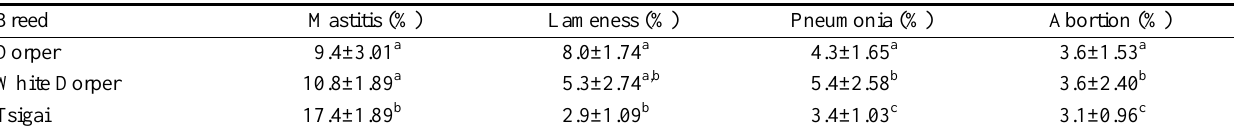
Table 2. Least squares means (±standard error) for occurrence rate of mastitis, lameness, pneumonia and abortions in Dorper, White Dorper, and Tsigai